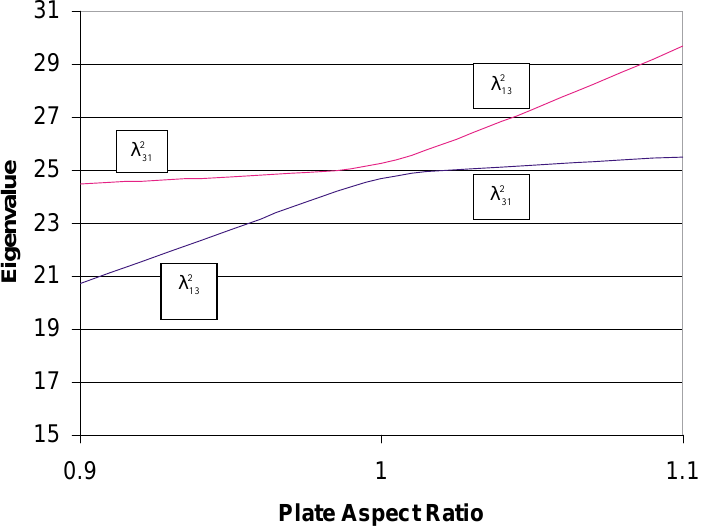
Fig. 3. Eigenvalues of rectangular membranes ( ε = 10 ,φ ∗ 13 = φ 13 + g 1 ,φ ∗ 31 = φ ∗ 31 = φ 31 + g 2 ).